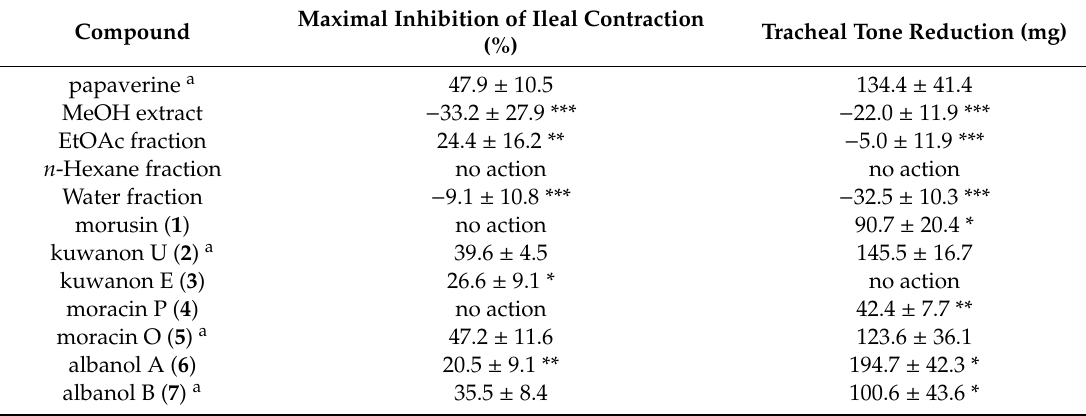
Table 1. Activity of the crude extract, pre-purified fractions and purified constituents of Morus nigra L. in a 3-point assay on isolated rat ileum and trachea. Papaverine was used as a positive control. The extract and fractions were administered at 0.01, 0.03 and 0.1 mg / mL, and the pure compounds at 10 − 8 , 10 − 7 and 10 − 6 M concentrations.